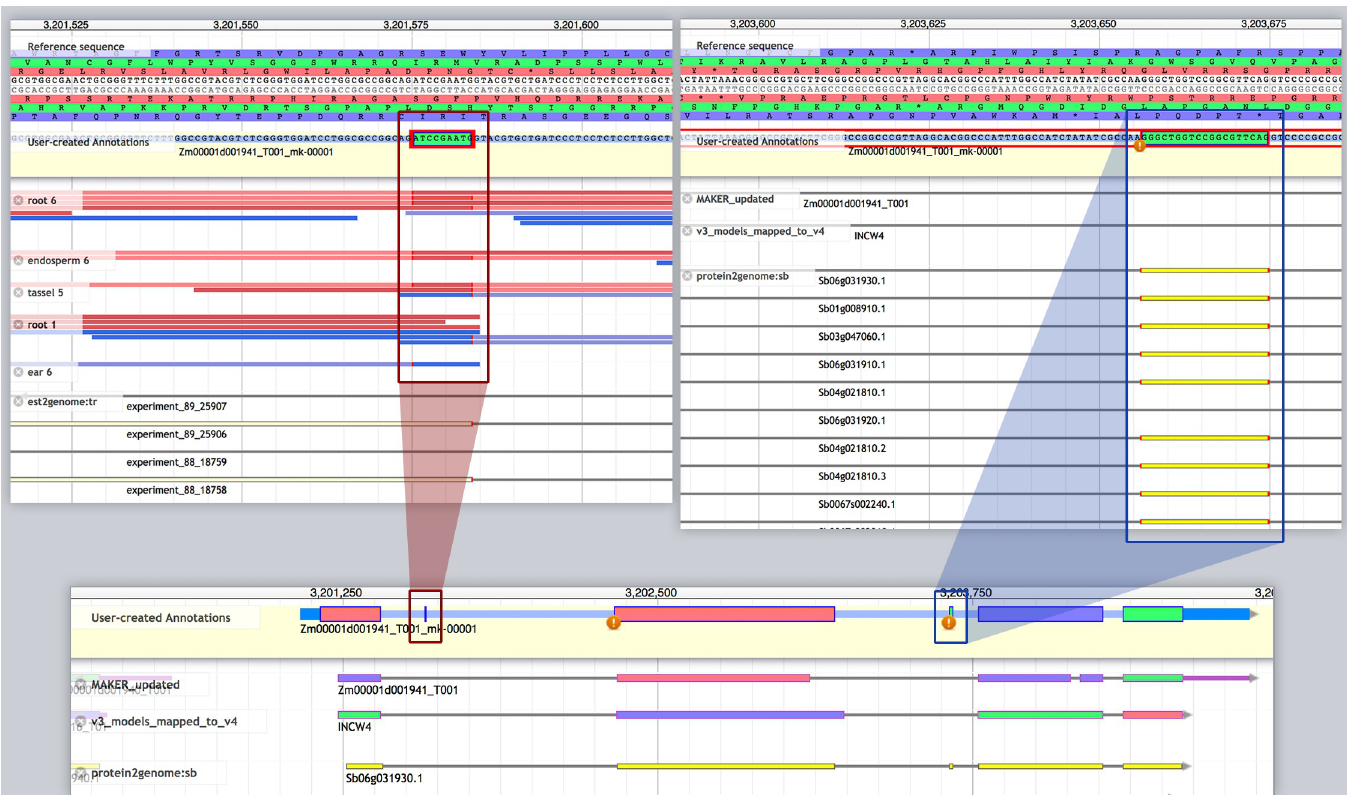
Fig 4. Curation of two mini-exons in INVCW4 (Zm00001d001941). The Apollo editing window shows a “User-created annotation” at top, followed by incorrect B73 RefGen_V4 model (“MAKER_updated”) and “v3 model mapped to v4.” A conserved 9-nucleotide exon (red circle) and a novel 19-nucleotide exon (blue circle) were supported by protein sequences from sorghum and rice, assembled EST transcripts from ultra-deep sequencing, long Iso-Seq reads combined from six tissues, and RNA- seq from root and other tissues.